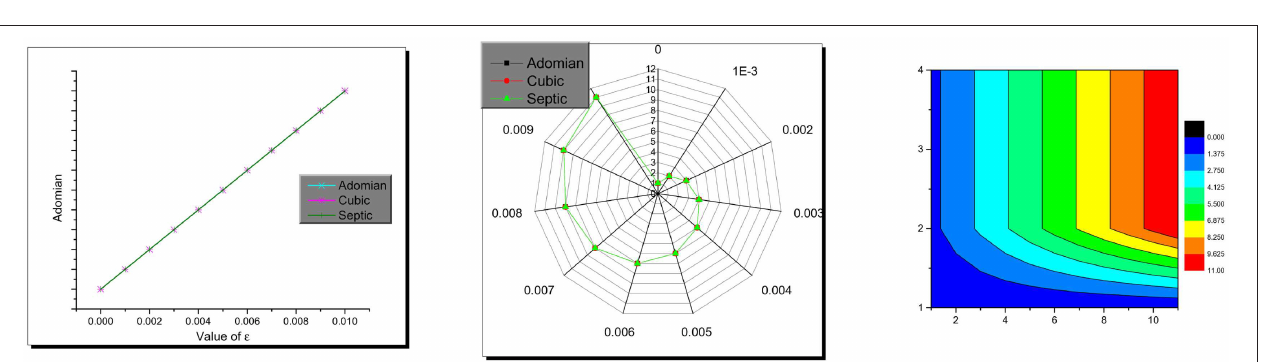
Frontiers in Physics |